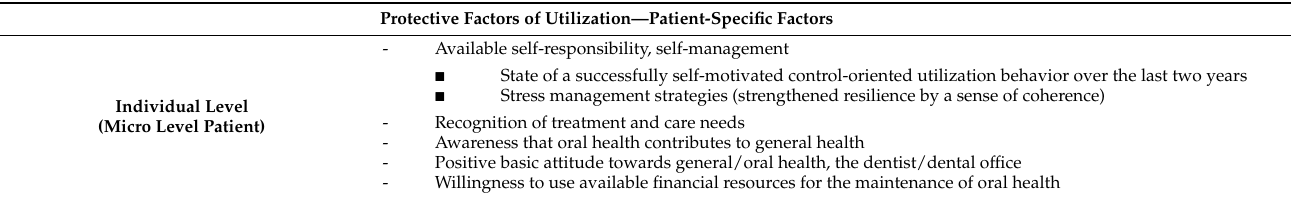
Table 2. Protective factors of utilization—patient-specific factors for the self-motivation of a control-oriented utilization of dental care (listing and organization with magnitude of importance based on expert panel).